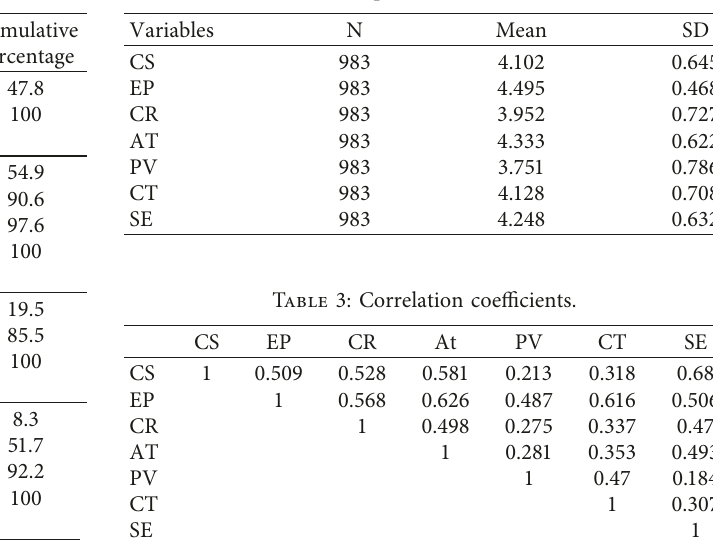
Table 1: Sample profile. Table 2: Descriptive statistics of variables.